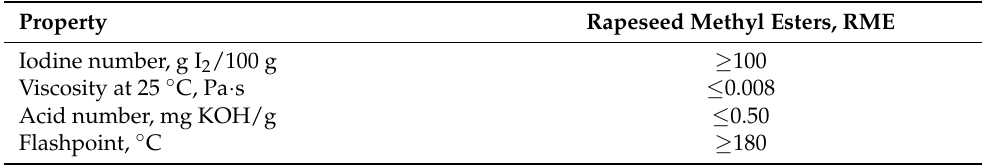
Table 2. Selected properties of the pure RME for producing the Bioflux fluxing agent.